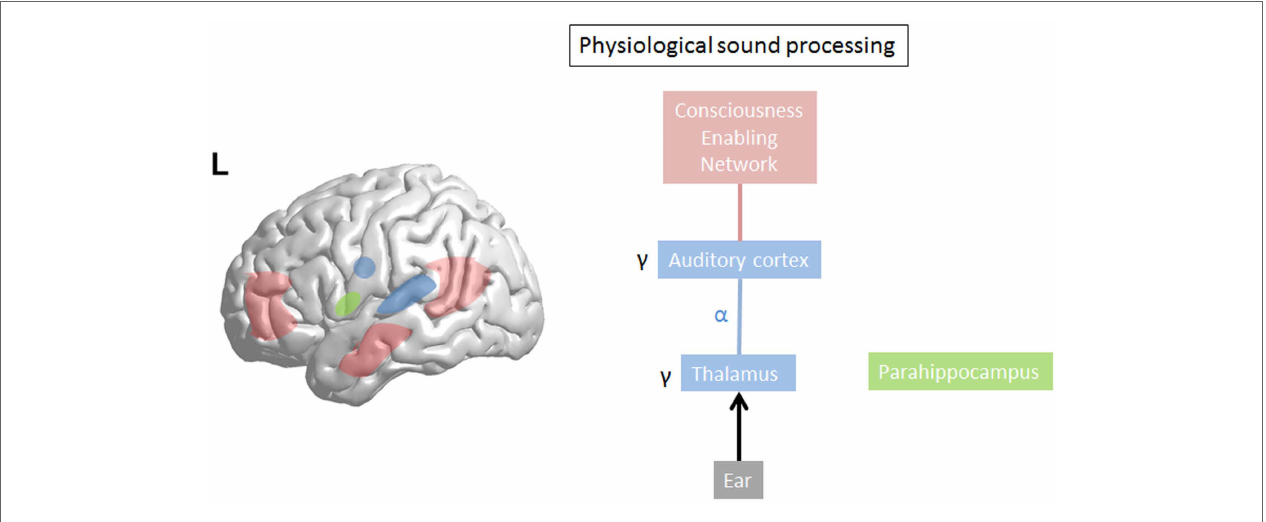
workspace) is co-activated with sound perception. The last sound presentation is stored in the (para)hippocampal area as a reference for future input to calculate the prediction